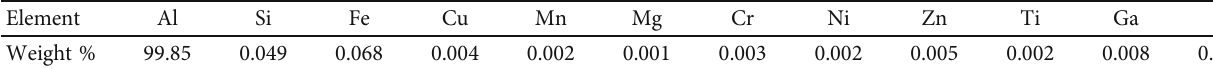
Table 1: Aluminium coupon composition as evaluated by OES.